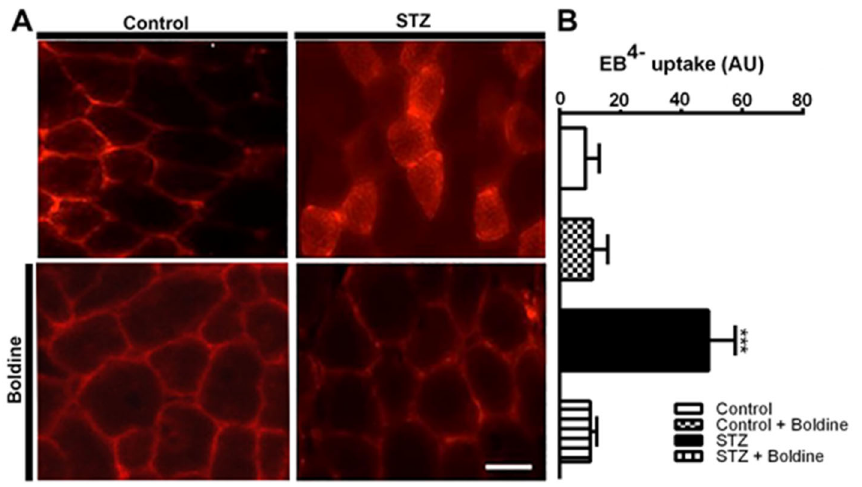
Figure 2. Boldine reduces the sarcolemma permeability of skeletal myofibers in diabetic rats. ( A ), Control and diabetic (STZ) rats treated or not with boldine for 3 weeks were injected i.p. with Evans blue (80 mg/kg). Tibialis anterior muscles were dissected 5 h post-injection. Evans blue (EB 4 − ) was detected as red staining. Scale bar: 50 µ m. ( B ), Quantification in arbitrary units (AU) of EB 4 − inside the fibers (red signal) from images like show in ( A ), Boldine totally corrected the sarcolemma permeability. The red staining depicts the presence of the dye surrounding myofibers (control, control + boldine, and STZ + boldine) or within the myofibers (STZ). *** p < 0.001. (N = 5 animals per group and ten images per animal were analyzed (around 500 fibers per